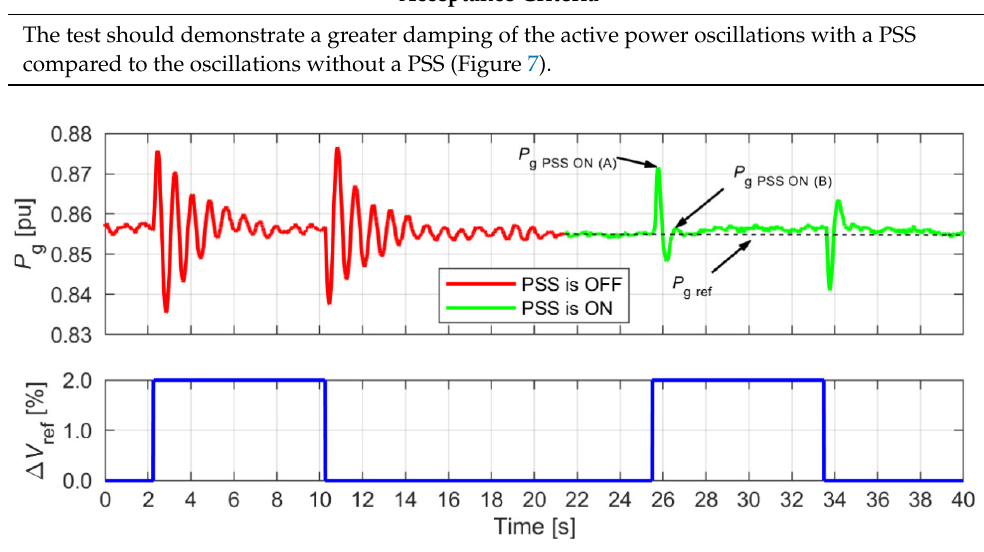
Figure 7. PSS step-response test with PSS OFF and PSS ON [39].